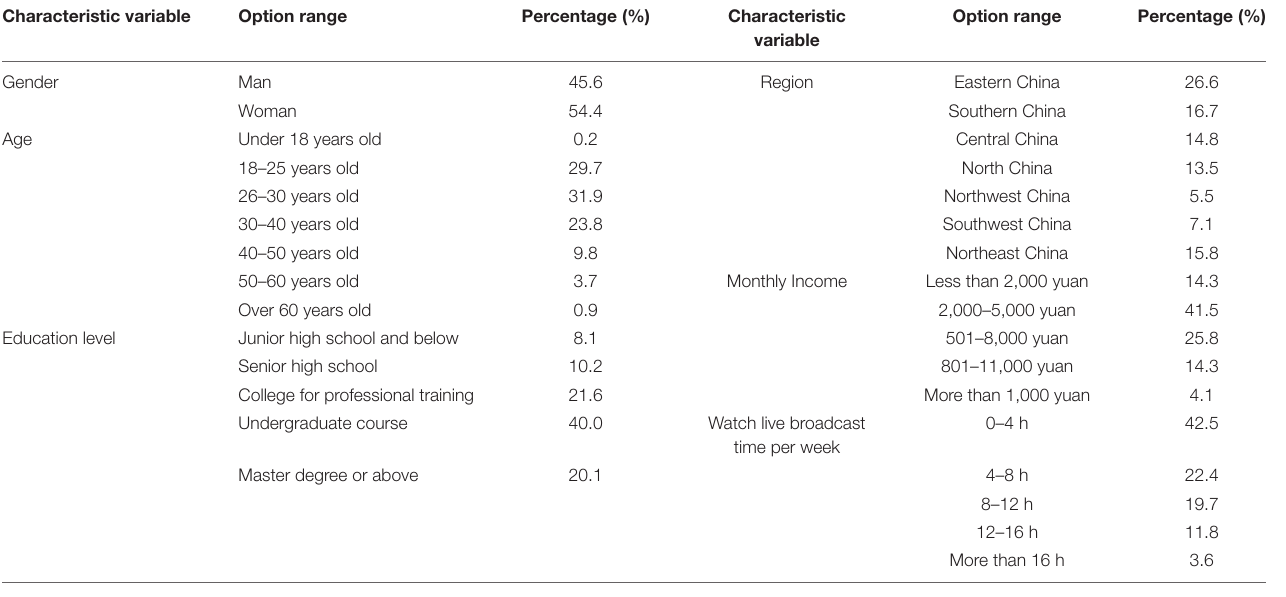
TABLE 2 | Descriptive statistics of the sample.